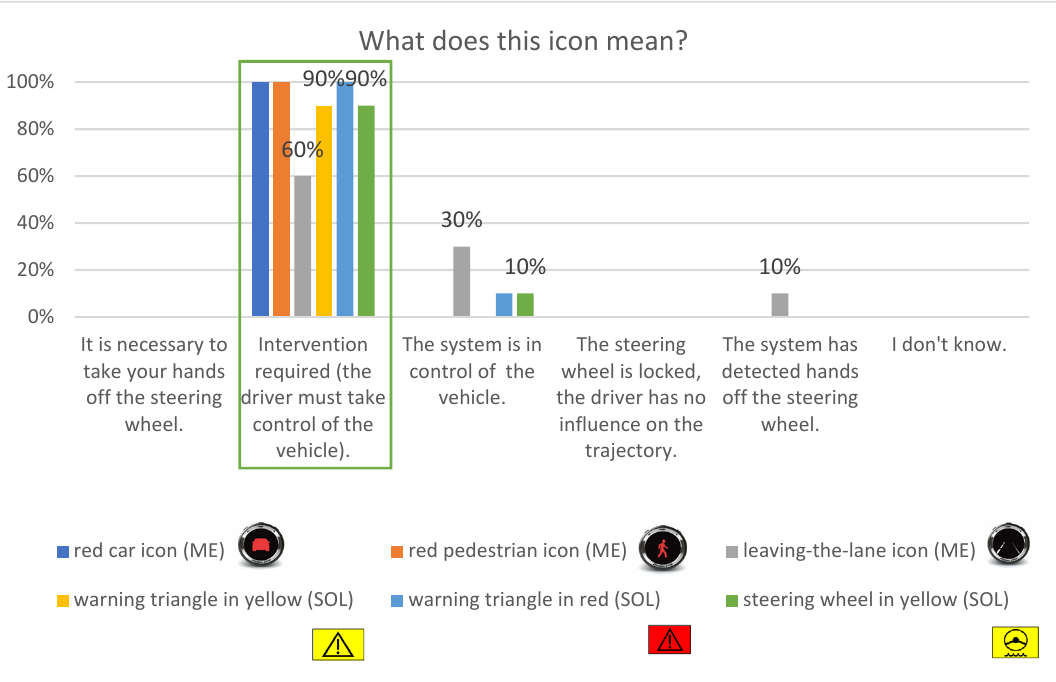
Figure 5. Comprehension Test, assessing the comprehension of the message conveyed by the icons (“What does this icon mean?”).